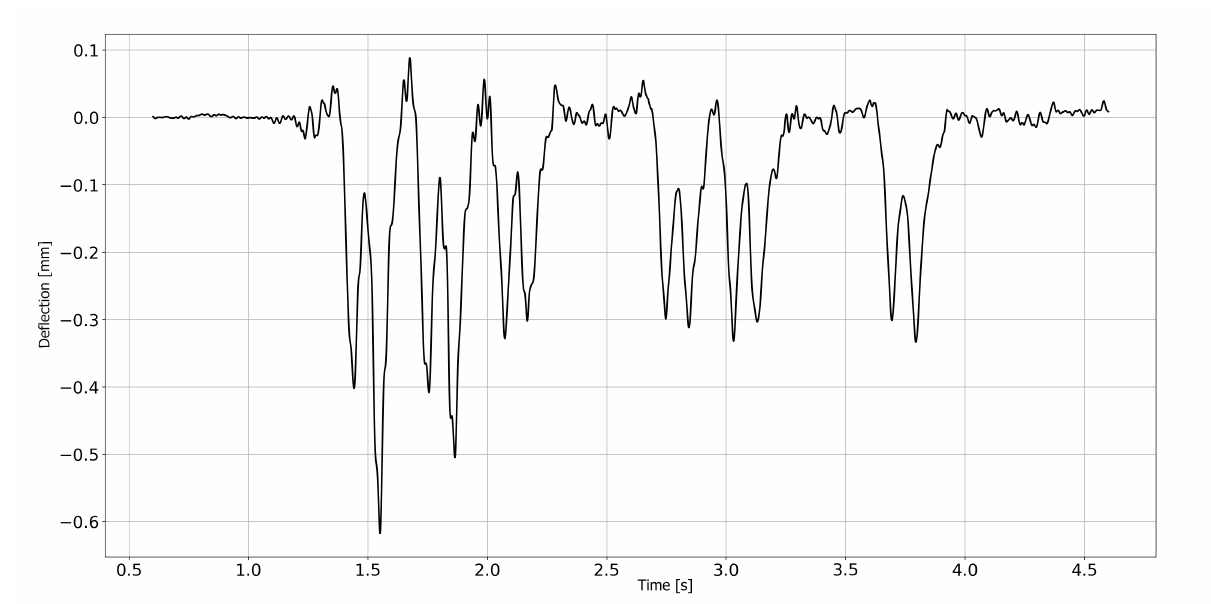
Figure 4. Measured in-situ